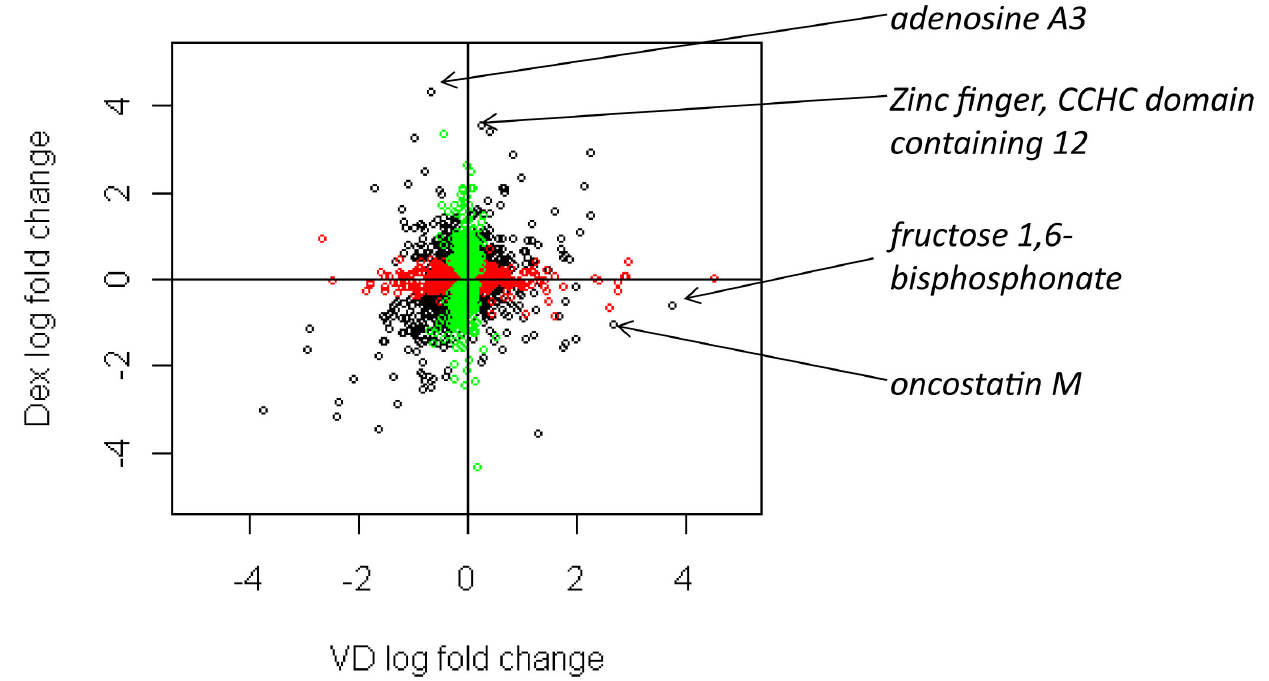
Figure 3. Scatterplot showing log fold change of differentially expressed genes in response to vitamin D (VD) and 2 dexamethasone (dex) on the x- and y-axes respectively after 24 hours. Each circle represents an individual gene. Black circles indicate genes that are differentially expressed in response to both 1,25 vitamin D and dexamethasone treatment. Red circles are genes that are differentially expressed only in response to 1,25 vitamin D treatment; while, green circles are genes that are differentially expressed only in response to dexamethasone treatment. Names of select differentially expressed genes are indicated that show marked differences in response to 1,25 vitamin D and dexamethasone at 24 hours including fructose 1,6 bisphosphonate (log fold change 3.79 vs. -0.61 in vitamin D vs. dexamethasone, respectively), oncostatin M (log 2 respectively), adenosine A3 (log fold change -0.66 vs. 4.31 respectively), and zinc finger, CCHC domain containing 12 (log 2 change 0.27 vs. 3.51